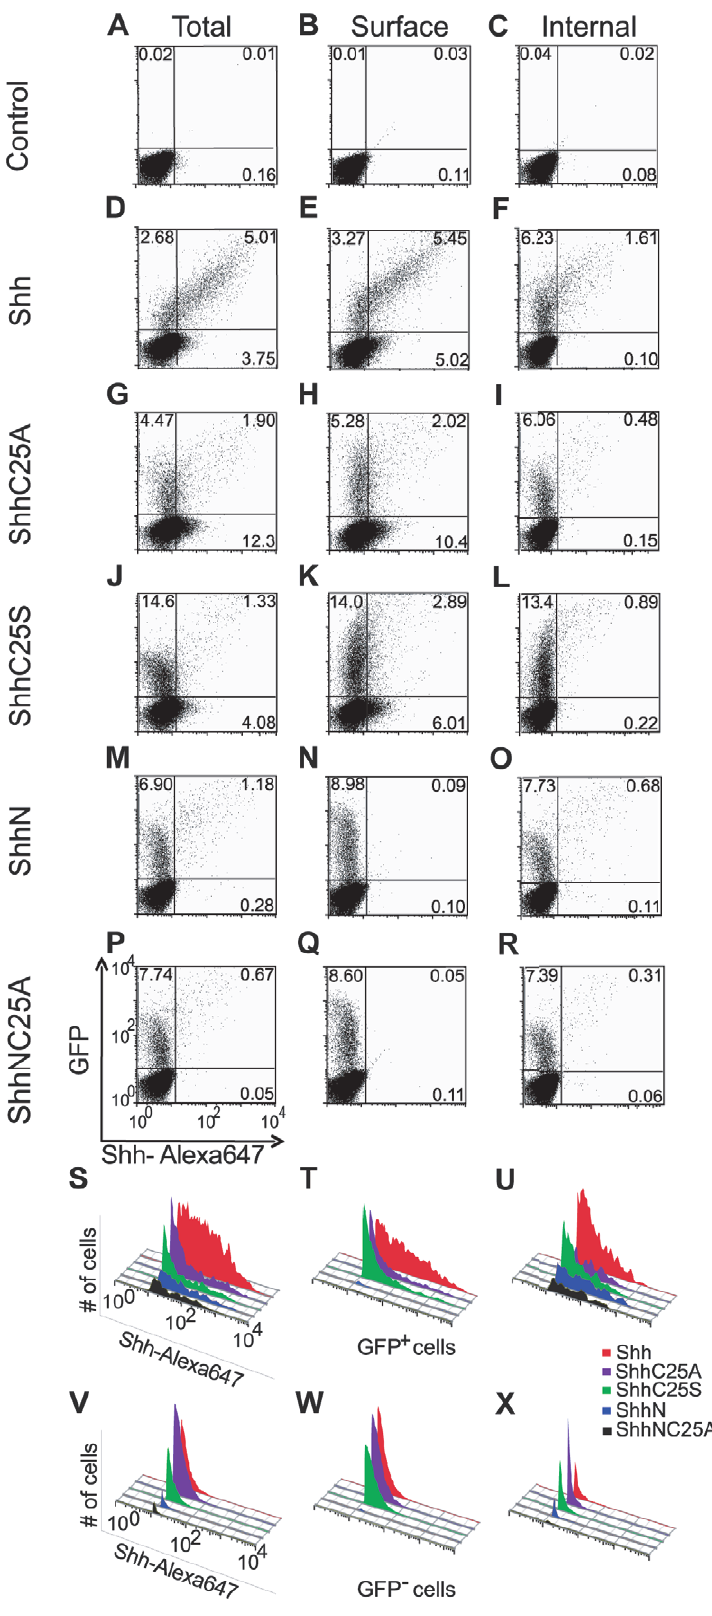
Figure 3. Cholesterol is required for expression of Shh on the cell surface. Shown are flow cytometric data from NIH3T3 fibroblasts co- transfected with recombinant Shh variants (0.125 ng) and EGFP (1000 ng), and stained with 5E1-Alexa 647 conjugated antibody. Total cell staining was measured in permeabilized cells and surface staining was measured in non-permeabilized cells. Internal staining was measured in cells that were PLoS ONE |